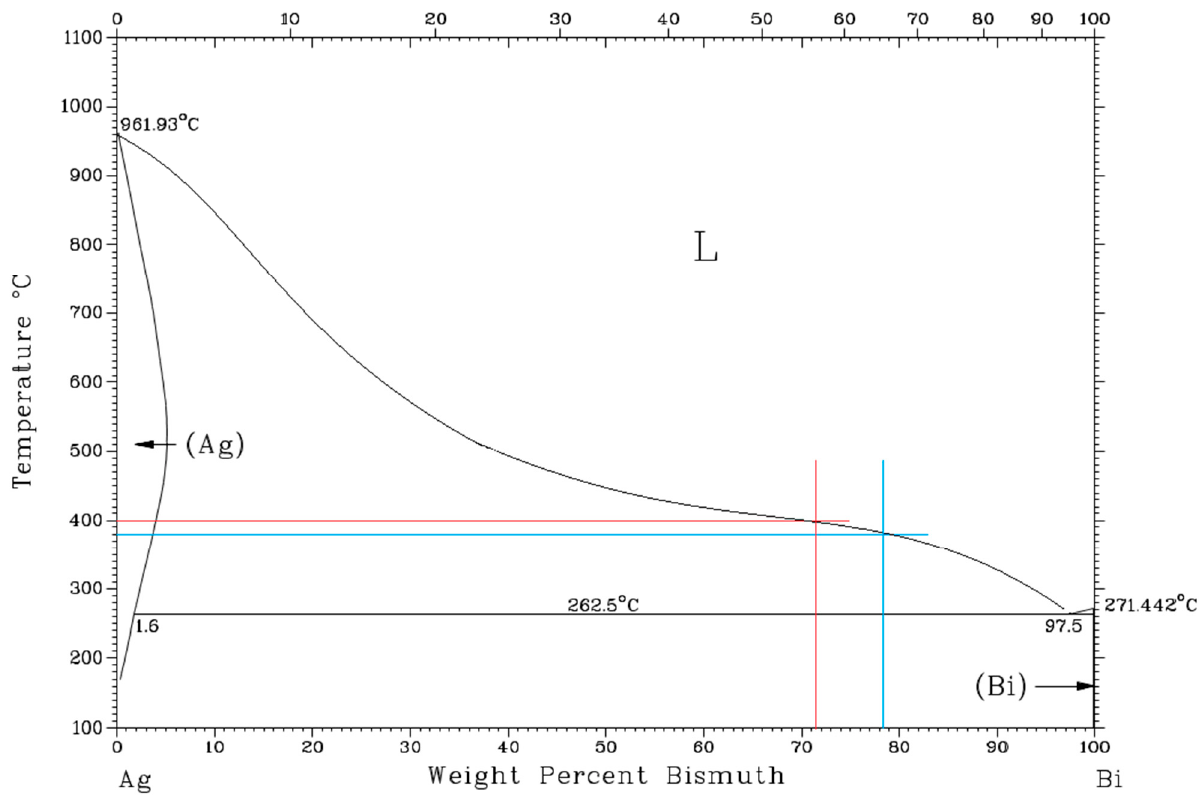
Figure 8. Binary diagram of silver–bismuth [35].